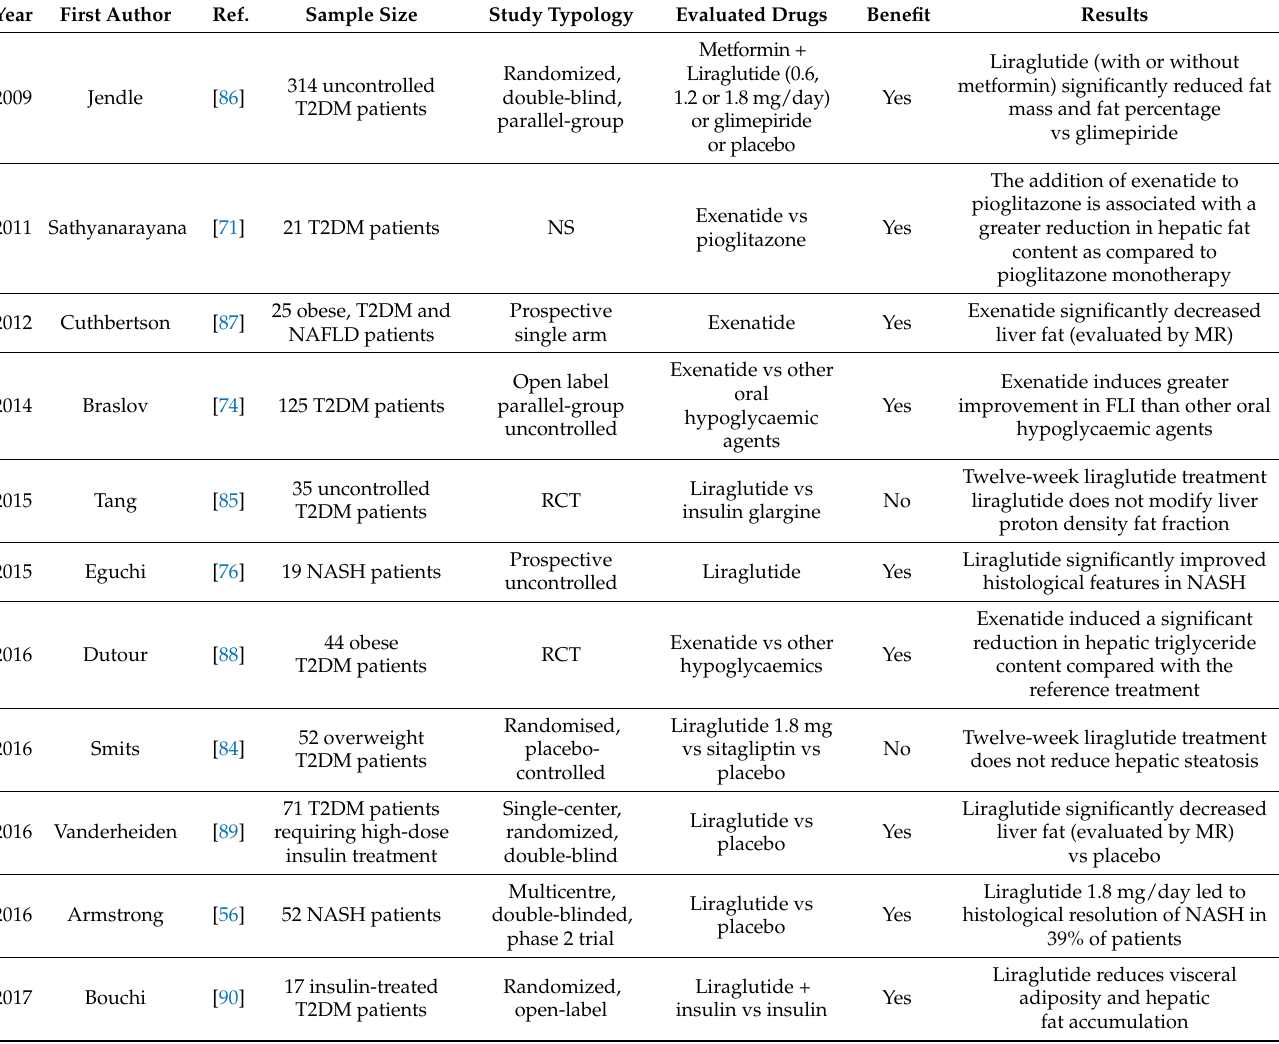
Table 3. Main evidences on the effect of GLP-1 RA on liver